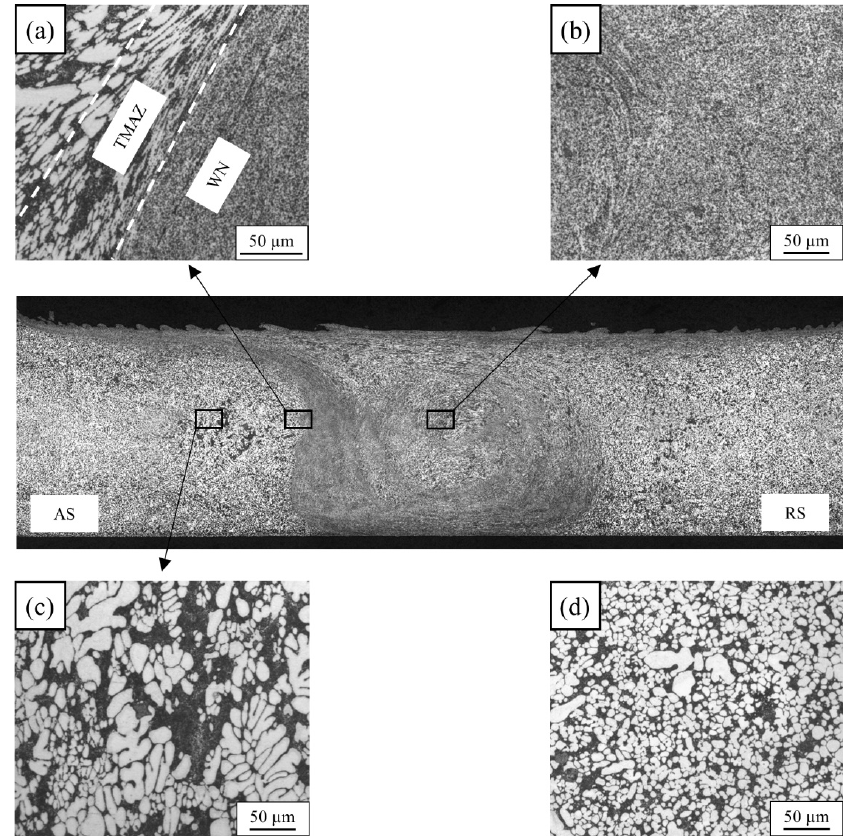
Figure 5. Cross-section and typical microstructural zones of a cast aluminum alloy FSW joint of AlSi10MnMg alloy at 500 mm/min: ( a ) thermomechanically affected zone (TMAZ); ( b ) weld nugget (WN); ( c ) heat affected zone (HAZ); and ( d ) base material .